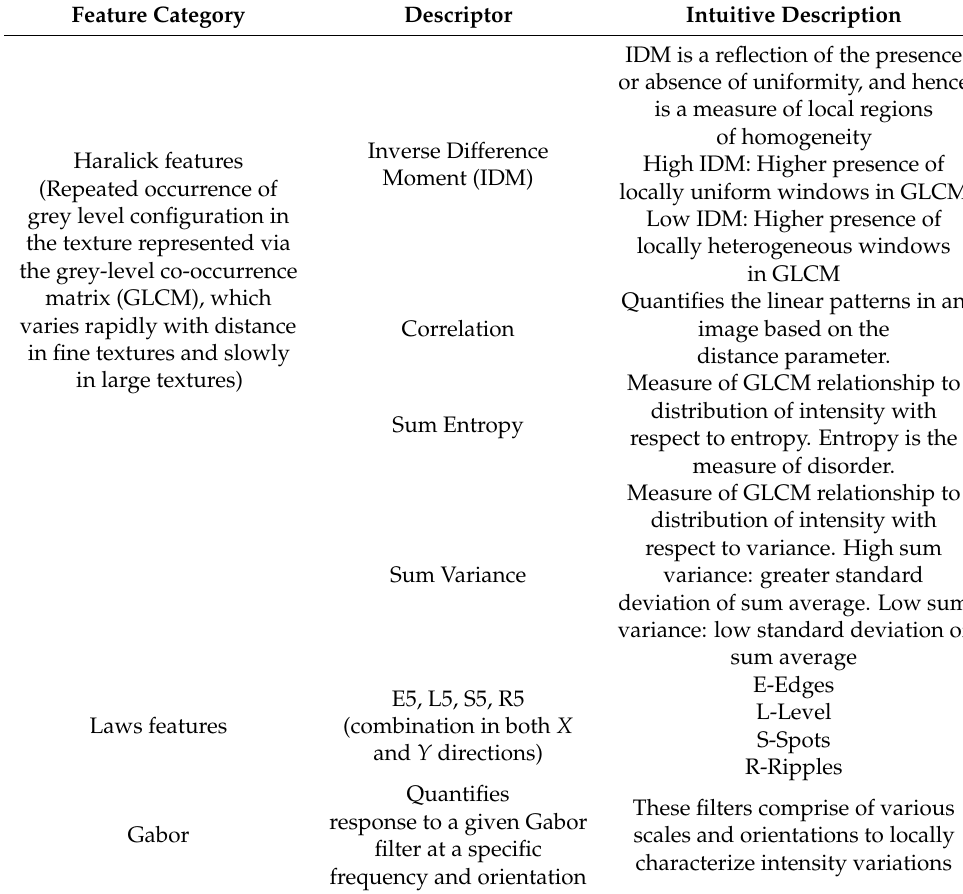
Table A2. Extracted textural feature categories and their